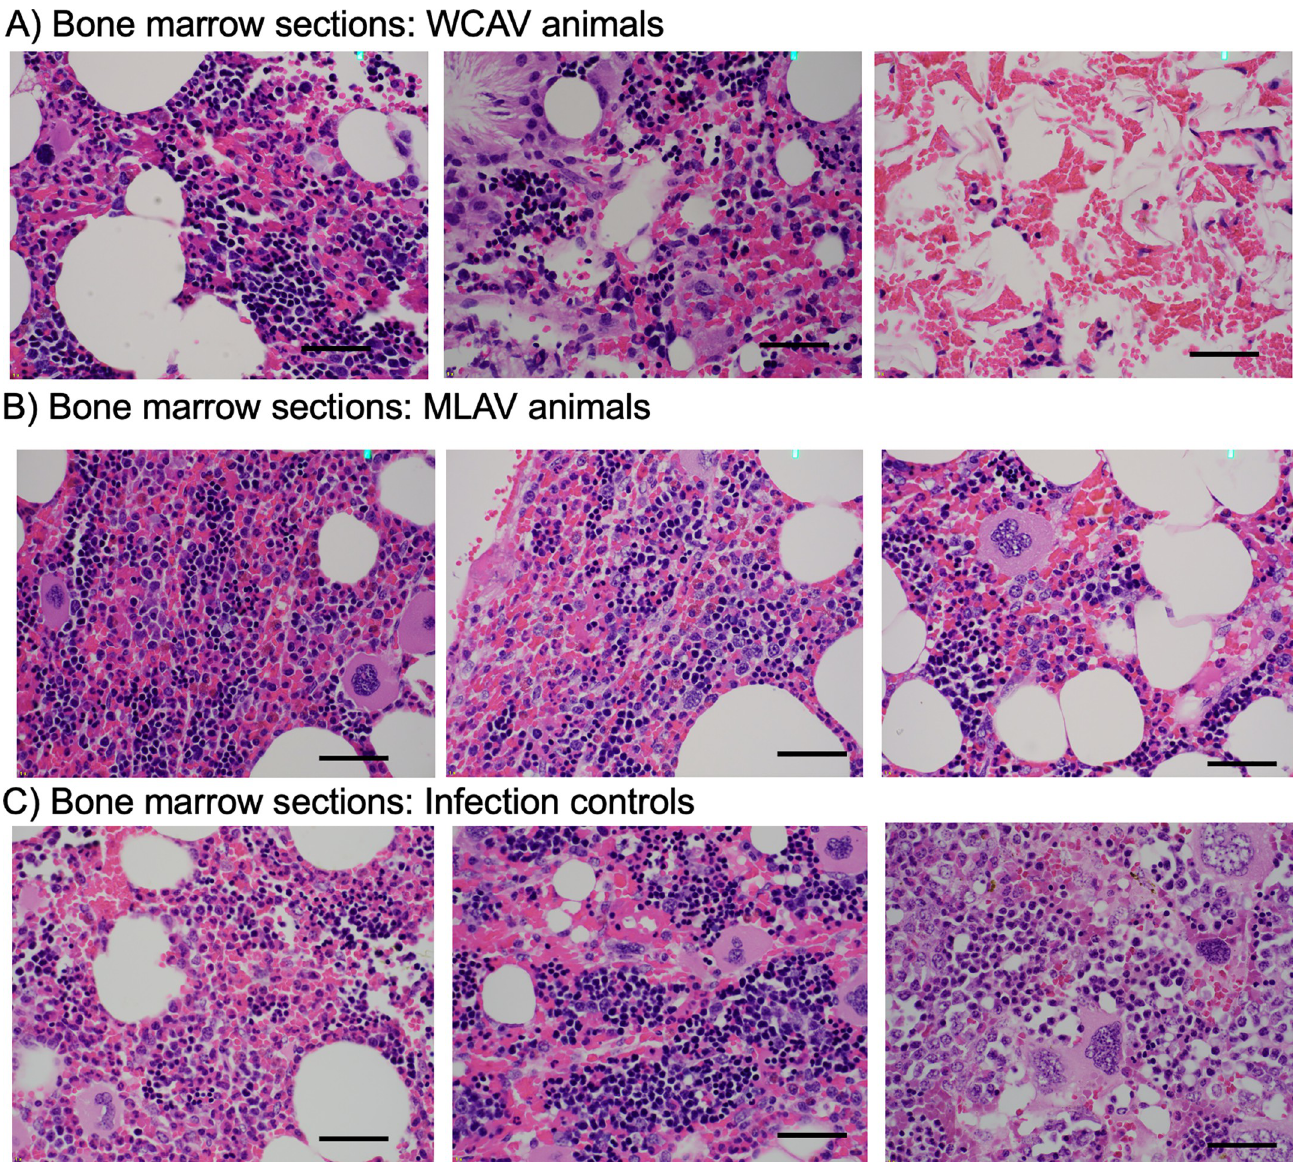
Fig 8. Post infection challenge histopathology sections of bone marrow at 40x magnification. From left to right panels: A) WCAV vaccinees (4491, 4502 and 4505); B) MLAV vaccinees (DP324, 4506 and HH5); C) Infection controls (4405, 4406 and HH6).